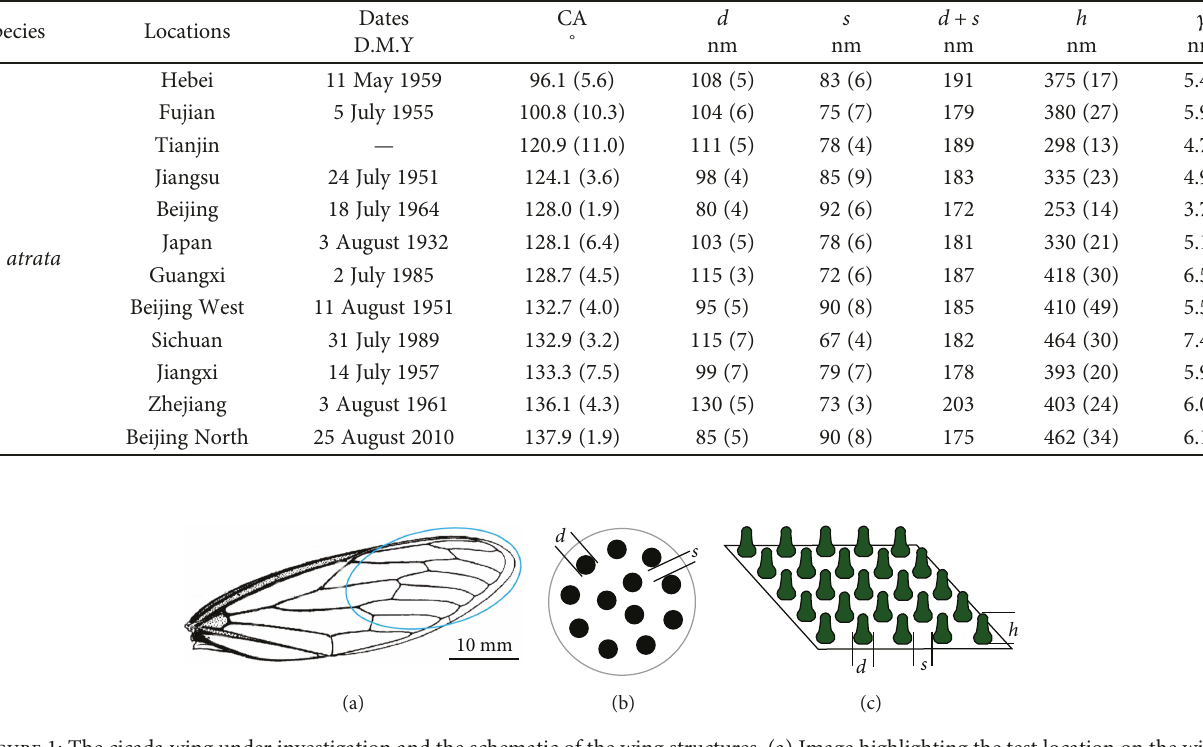
Table 1: Collection locations, dates, contact angles, and nanostructure parameters of the cicada Cryptotympana atrata . The contact angle (CA), basal diameter ( d ), basal spacing ( s ), and height ( h ) values of protrusions are the average values and standard deviations across the forewing of a single specimen. The roughness factor ( γ ) was calculated using (2), which is derived from the Wenzel model. The mark ( — ) indicates the collecting date of the sample is not